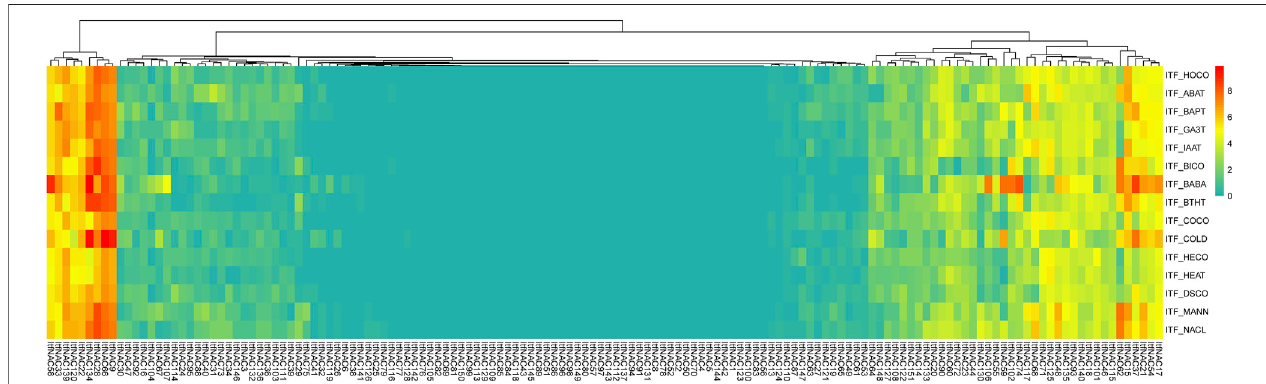
FIGURE10| Expressionpro fi lesofItfNACgenesundervariousstressesinwildsweetpotatoIpomoeatri fi da.ThetranscriptabundancewasexaminedusingRNA- Seq gene expression data. The expression pro fi les were calculated via a heat map from the log2 (FPKM+1) value, and shown as ablue-yellow-red gradient by using the heat map package in R version 3.4.0. HOCO, hormone control; ABAT, ABA treatment; BAPT, BA treatment; GA 3 T, GA 3 treatment; IAAT, IAA treatment; BICO, biotic stress control; BABA, beta-aminobutyric acid treatment; BTHT, benzothiadiazole S-methylester treatment; COCO cold control; HECO, heat control; DSCO, drought and salt control; MANN, mannitol drought